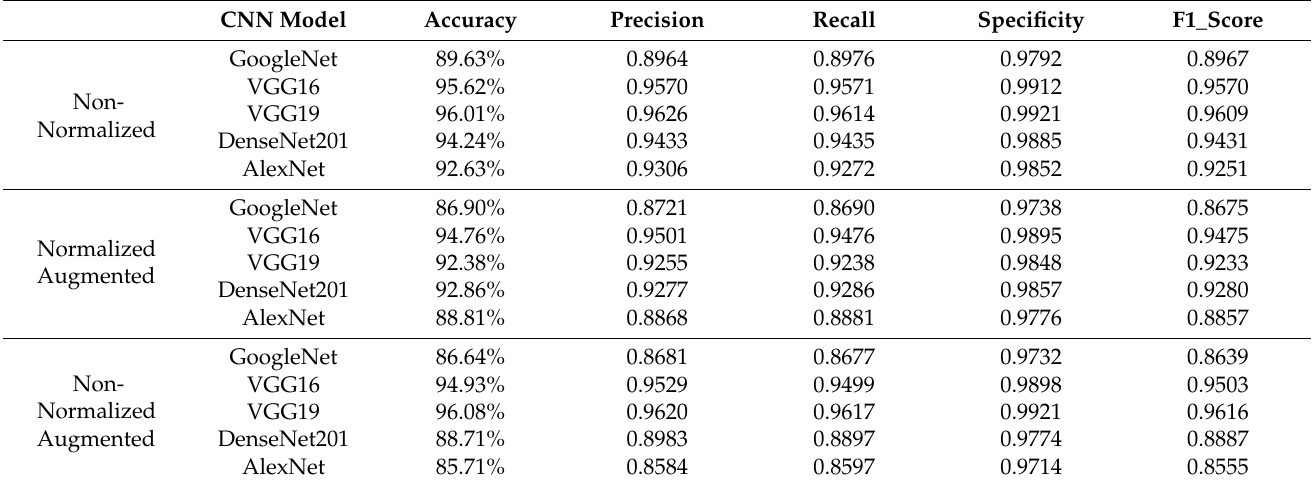
Table 4. Comparison of experimental results using transfer learning-based optimized weights with well-known CNN